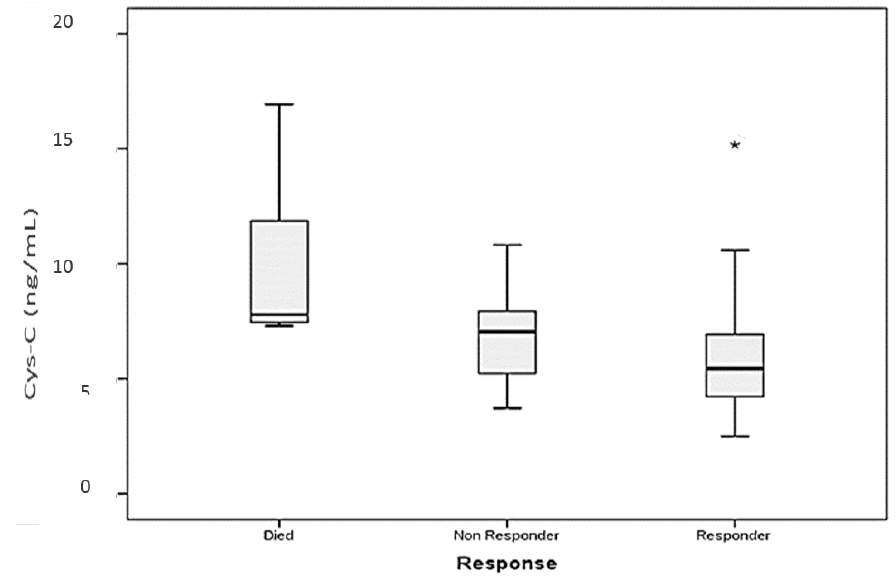
Figure 7. Box plot shows the difference in median and ranges of serum cystatin C (Cys-C) levels among responders, non-responders and patients who died. * Significant different ( p < 0.05).